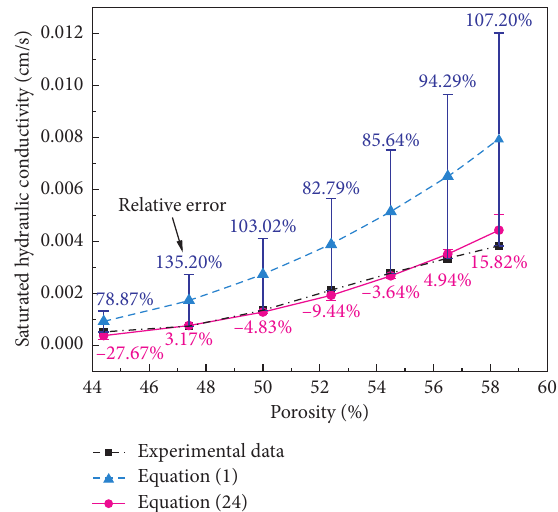
Figure 9: Capillary model versus original KC equation for C